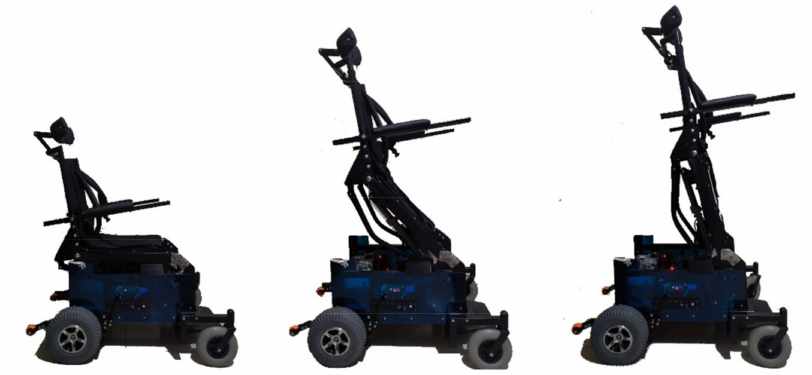
Figure 7. Standing wheelchair at different positions.